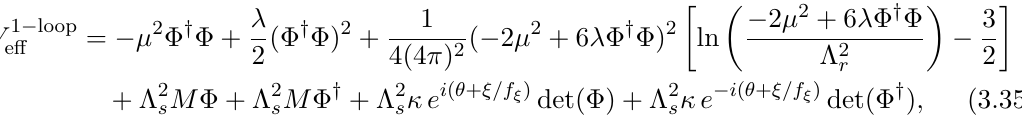
Figure 4 . E(cid:11)ects of the interaction between composite scalar (cid:8) and the non-trivial vacuum (due to non-perturbative physics) on a mexican hat potential V MH ( (cid:27) ) = (cid:0) (cid:22) 2 (cid:27) 2 + (cid:21) direction (cid:27) (left), expressed in units of (cid:3) s . Schematic representation of the one-loop corrections in the e(cid:11)ective potential in comparison to the classical potential V cl from (3.20) along the in(cid:13)adron direction (cid:27) (right). The one-loop e(cid:11)ective potential (green curve) is only depicted in the range where it takes real values. In the (cid:12)eld range where (cid:0) 2 (cid:22) 2 + 6 (cid:21) (cid:8) y (cid:8) < 0 the e(cid:11)ective potential becomes imaginary and non-convex, encoding information [111] about unstable (cid:13)uctuations due the tachyonic (local) maximum of the scalar